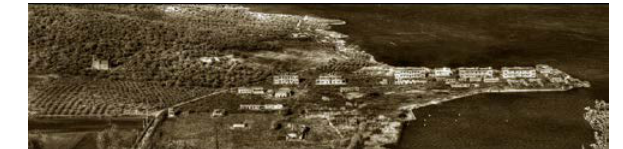
Figure 6. Aerial view of the